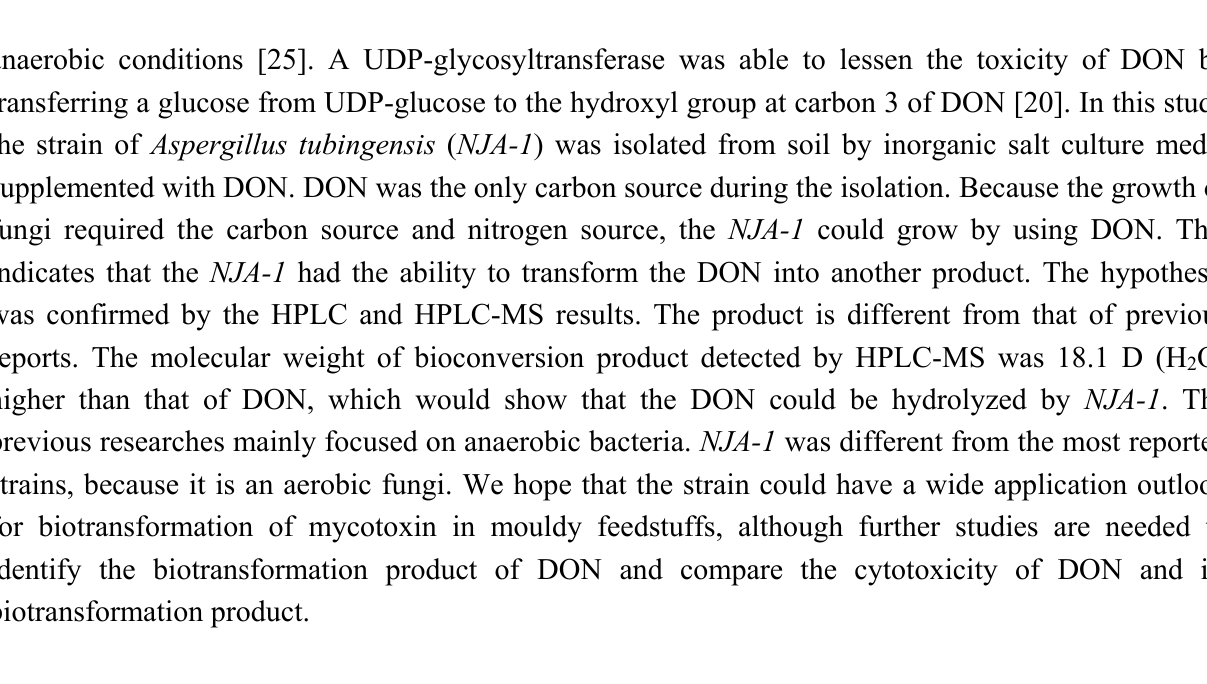
Figure 4. Fluorescence of the biotransformation product (Ex=340, Em=450) detected with HPLC equipped with fluorescence detector. The X axis = time (min), the Y axis = LU.